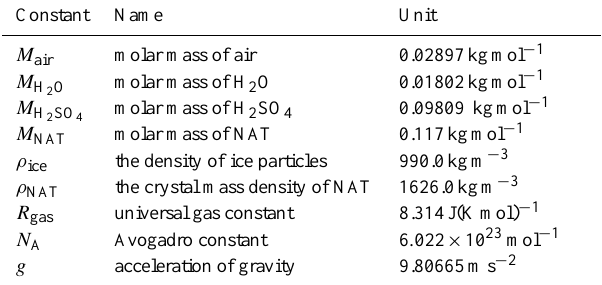
Table 1. Used constants in submodel